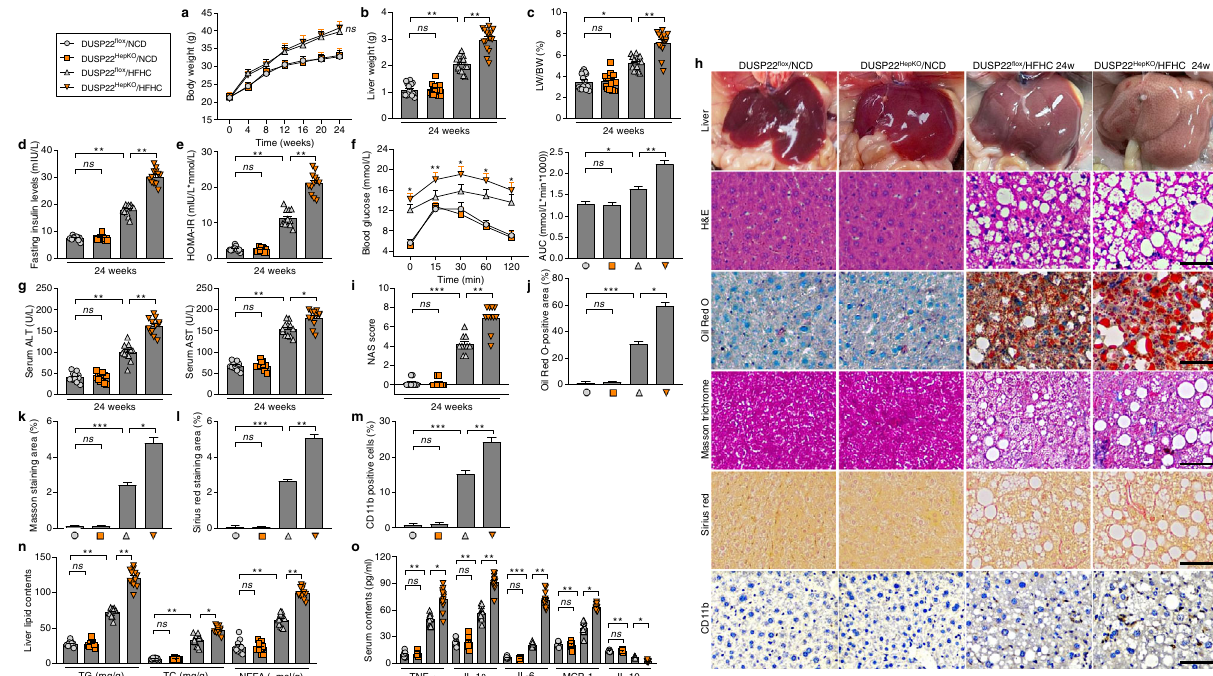
Fig. 2 | Hepatocyte-speci fi c DUSP22 knockout exacerbates HFHC-induced NASHpathologies.a – e Measurementsof a bodyweight, b liverweight, c theratio of liver weight to body weight (LW/BW) ( n =15 mice per group), d blood fasting insulin levels, and e HOMA-IR in DUSP22 fl ox and hepatocyte-speci fi c DUSP22 knockout(DUSP22 HepKO )micefedwithNCDoraHFHCfor24weeks( n =12miceper group) (* P <0.05 and ** P <0.01; ns no signi fi cant difference). f Glucose tolerance test (GTT) in DUSP22 fl ox and DUSP22 HepKO mice fed with a NCD or a HFHC for 24 weeks were performed, and area under the curve (AUC) values were calculated ( n =12 mice per group) (* P <0.05 and ** P <0.01; ns no signi fi cant difference). g SerumALTandASTlevelsinDUSP22 fl ox andDUSP22 HepKO micefedwithaNCDora HFHC for 24 weeks ( n =12 mice per group) (* P <0.05 and ** P <0.01; ns no sig- ni fi cant difference). h Representative images of liverappearance, H&E staining,Oil Red O staining, Masson trichrome staining, Sirius red staining and immunohis- tochemistry examination of CD11b in liver sections from DUSP22 fl ox and